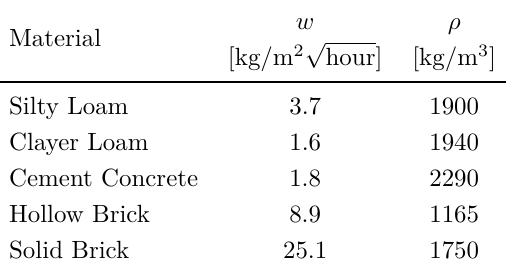
Table 2. Water Absorption Capacity Coefficient of common building materials